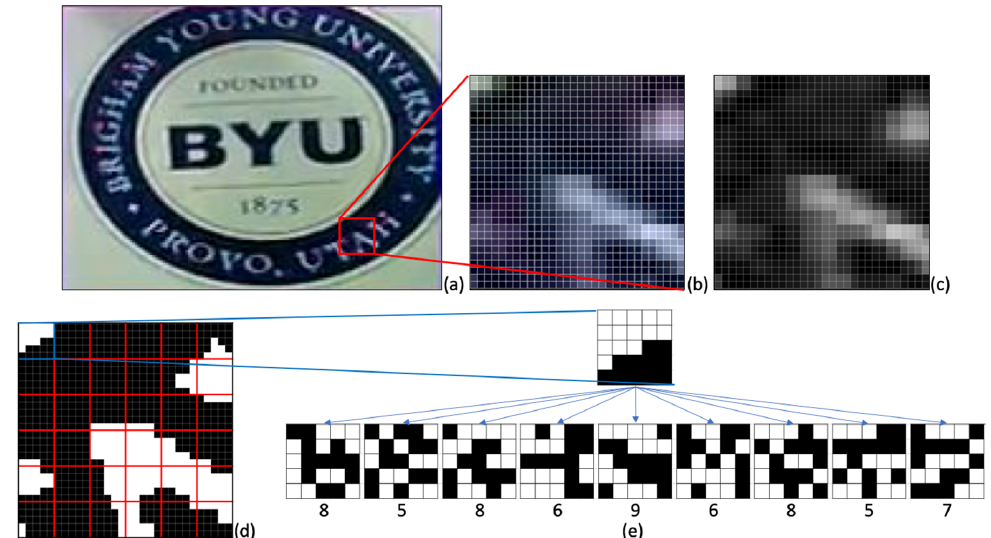
Figure 1. Algorithm flow. ( a ) The input image, ( b ) a 30 × 30 region surrounding the feature point, ( c ) grayscale image of the feature region of interest (FRI), ( d ) binary FRI, and ( e ) similarity measure. The SYBA algorithm divides the 30 × 30 FRI into 36 5 × 5 subregions [8]. According to